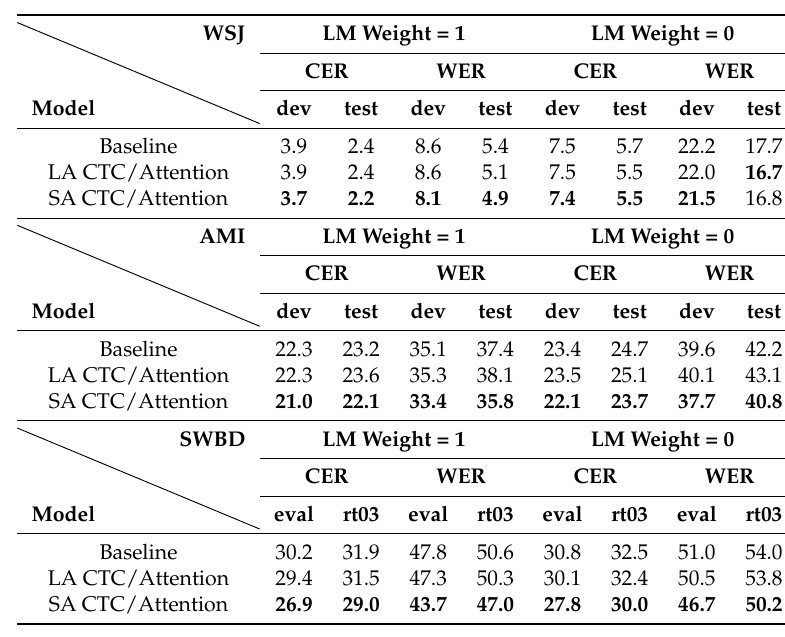
Table 3. The performances of the SA CTC/Attention for WSJ, AMI, and SWBD compared with the LA CTC/Attention and baseline